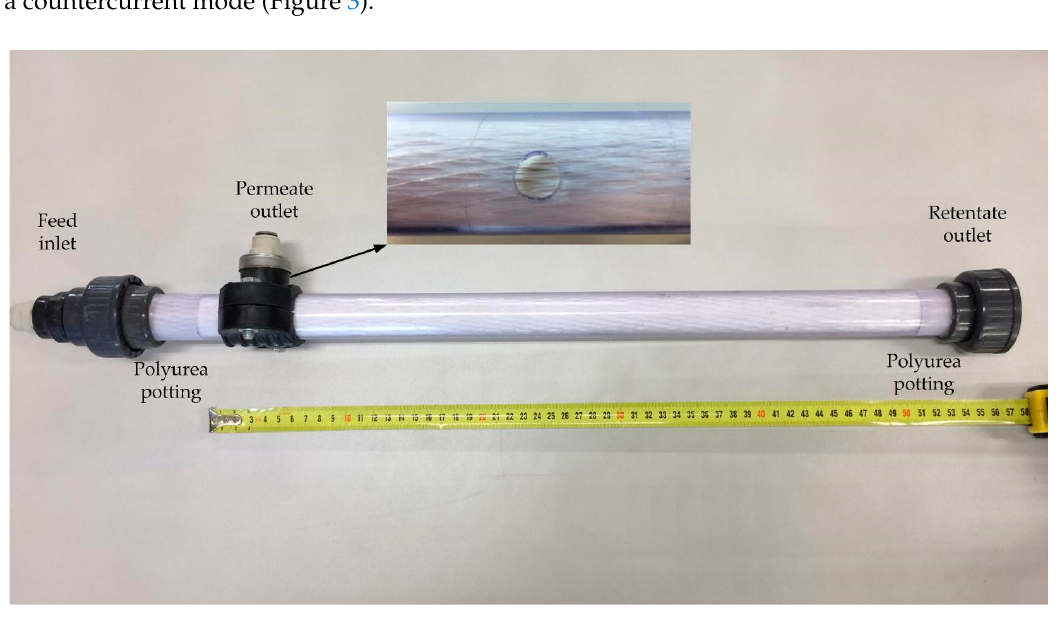
Figure 3. The photograph of the membrane element.